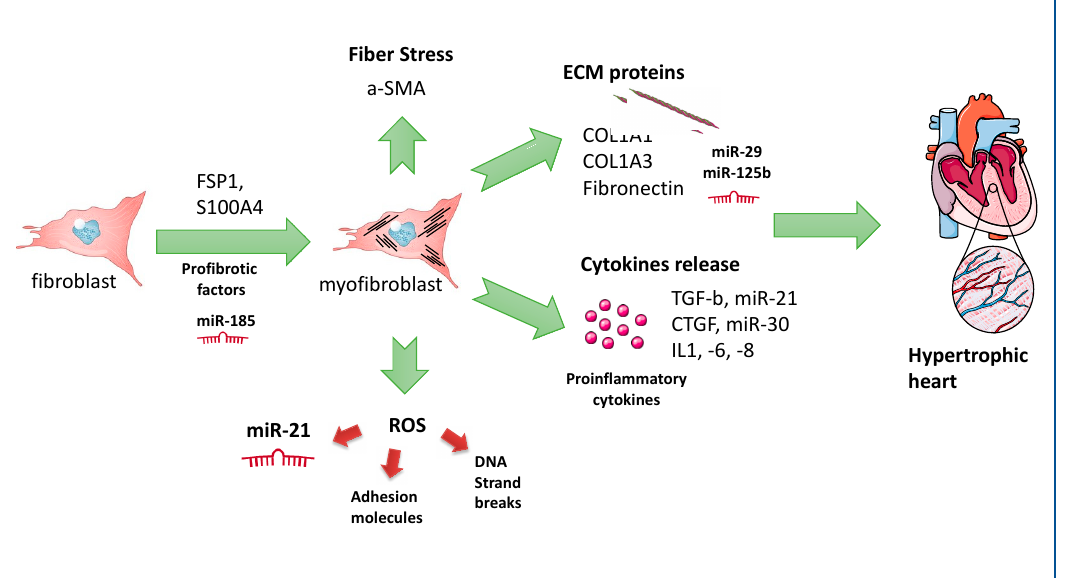
Figure 2. Depiction of the main mechanisms involved in the development of myocardial fibrosis. Upon injury, a fibroblast or other resident cells such as pericytes, endothelial cells, among others, release profibrotic factors including miR-185 to convert into a myofibroblast. The activation of a plethora of damaging agents such as ROS or proinflammatory cytokines and ECM proteins induces myocardial fibrosis and ultimately a hypertrophic heart.